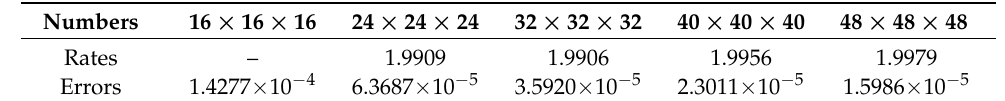
Table 4. The convergence rates and errors ω = 1.95, n = 3000.